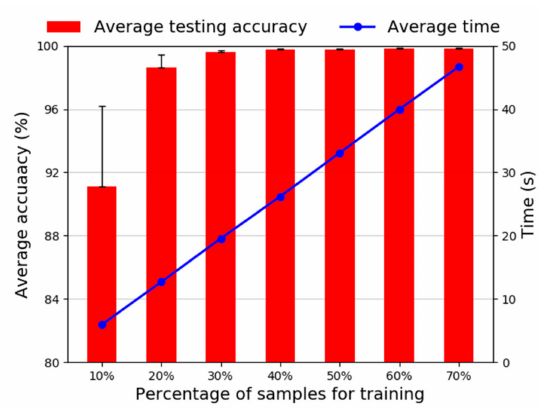
Figure 18. Diagnosis accuracy of di ff erent percentage of training